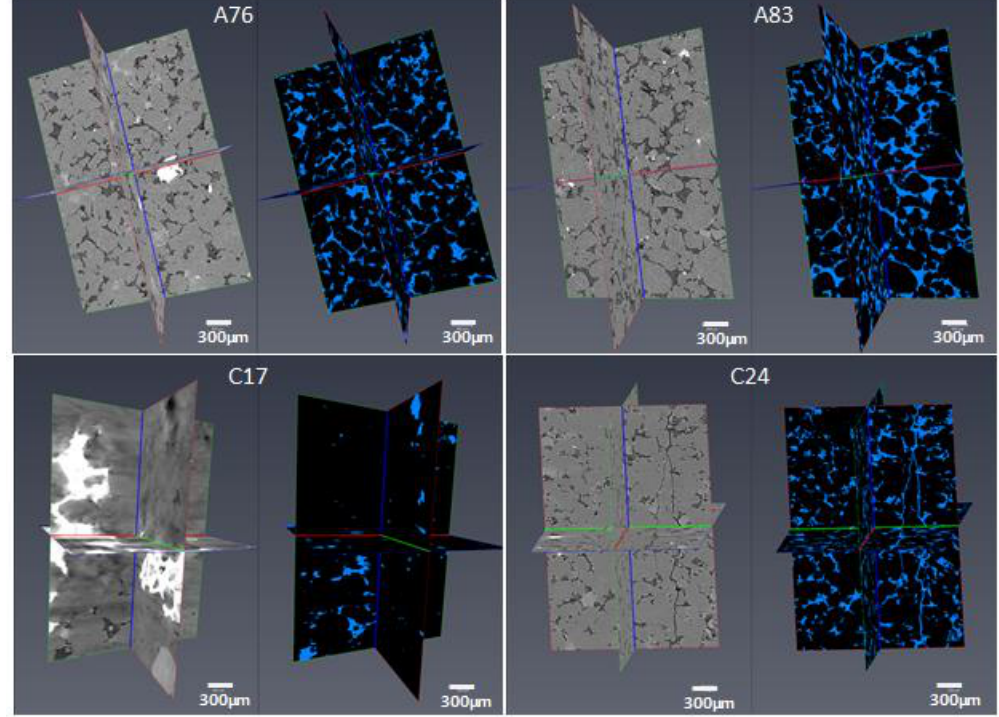
Figure 20. High-resolution µCT images and their segmentation for samples in group 2 (>7% porosity). CT images taken at 4-µm resolution.